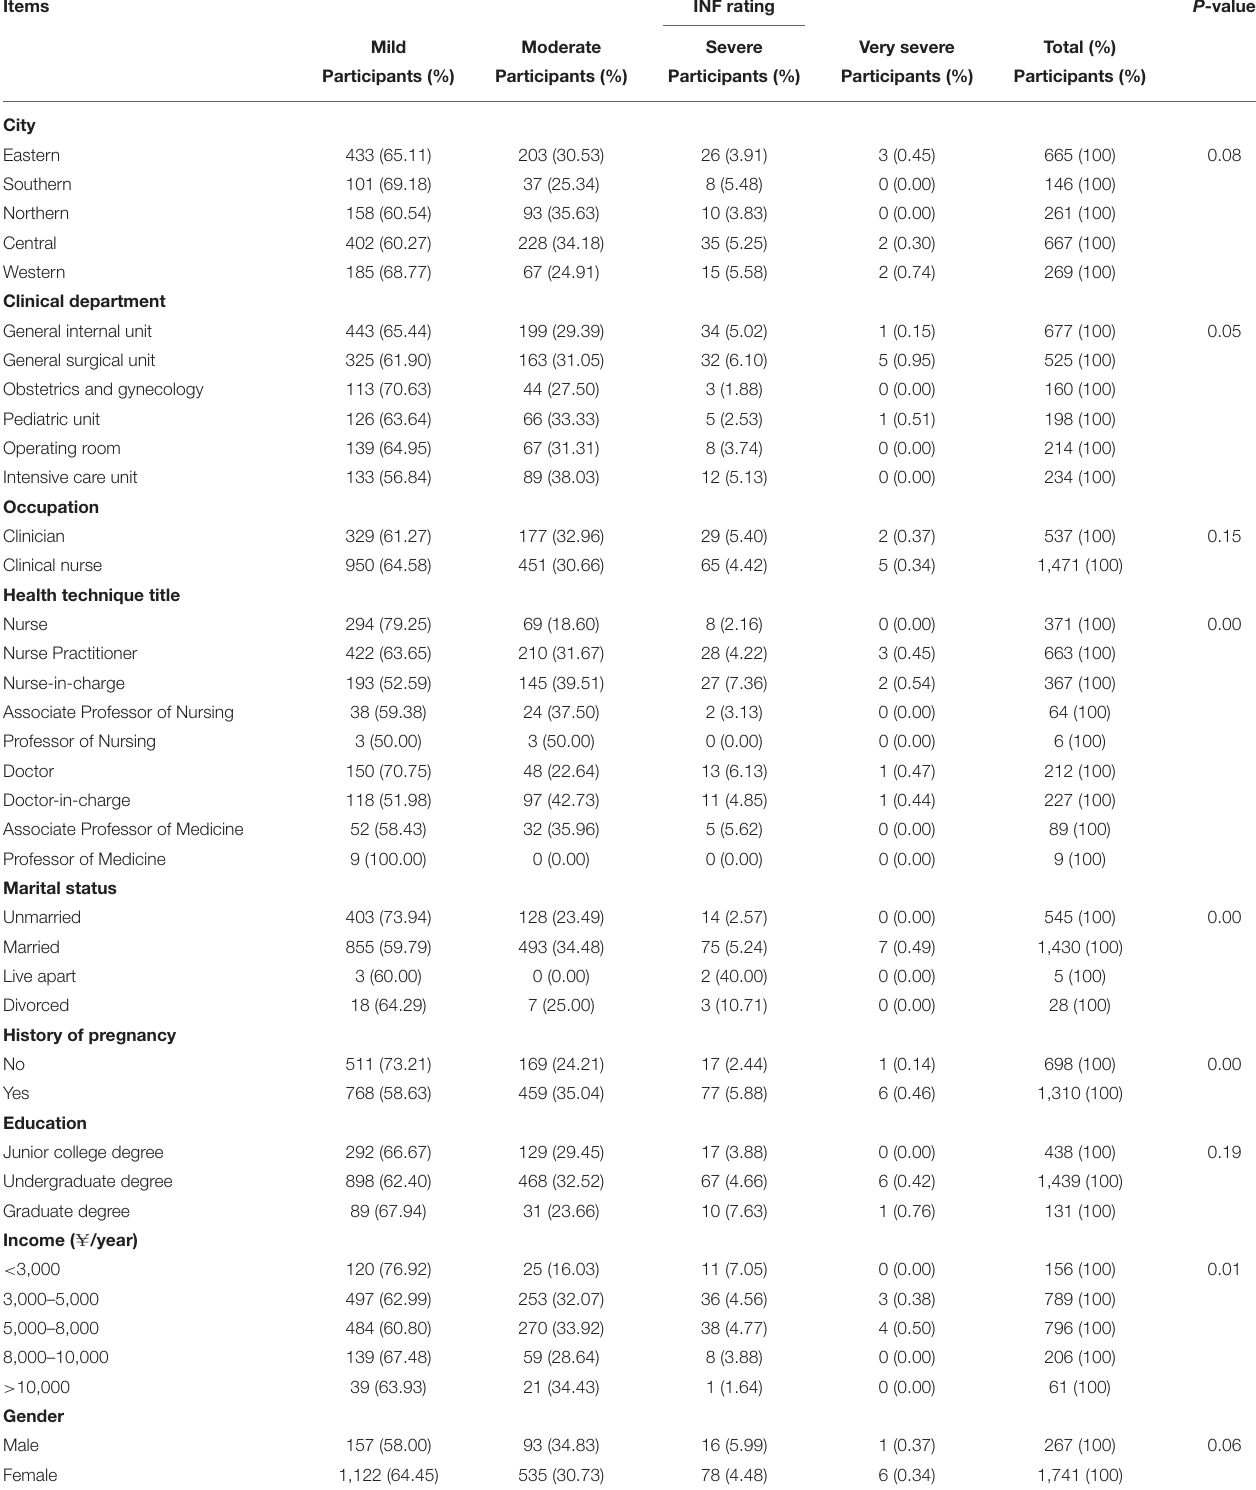
TABLE 1 | Demographic characteristics and prevalence of neck-shoulder pain in 2,008